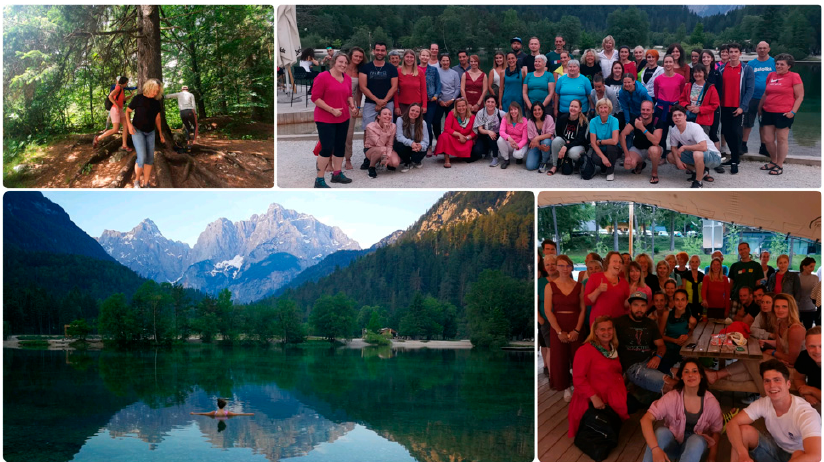
Figure 3. Of the fifty volunteers, forty-seven arrived and accommodated in the Kranjska Gora destination forest area.